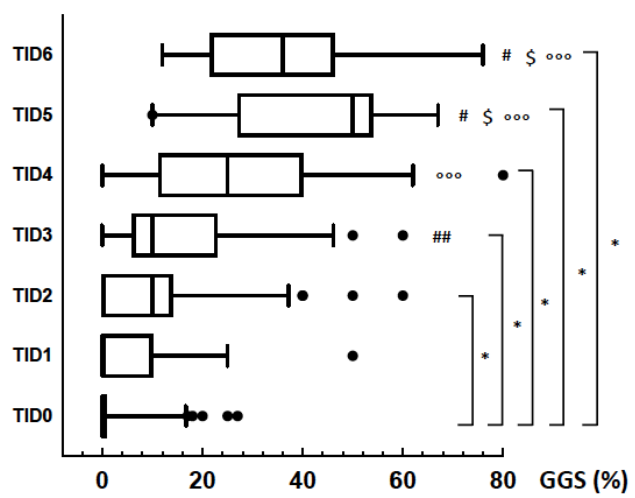
Figure 3. Distribution of TID score by GGS% in the patients with glomerulonephitis. *: p < 0.001 vs. TID 0; #: p < 0.0001 vs. TID 1; ##: p = 0.002 vs. TID 1; °°°: p < 0.001 vs. TID 2; $ p = 0.04 vs. TID 3.